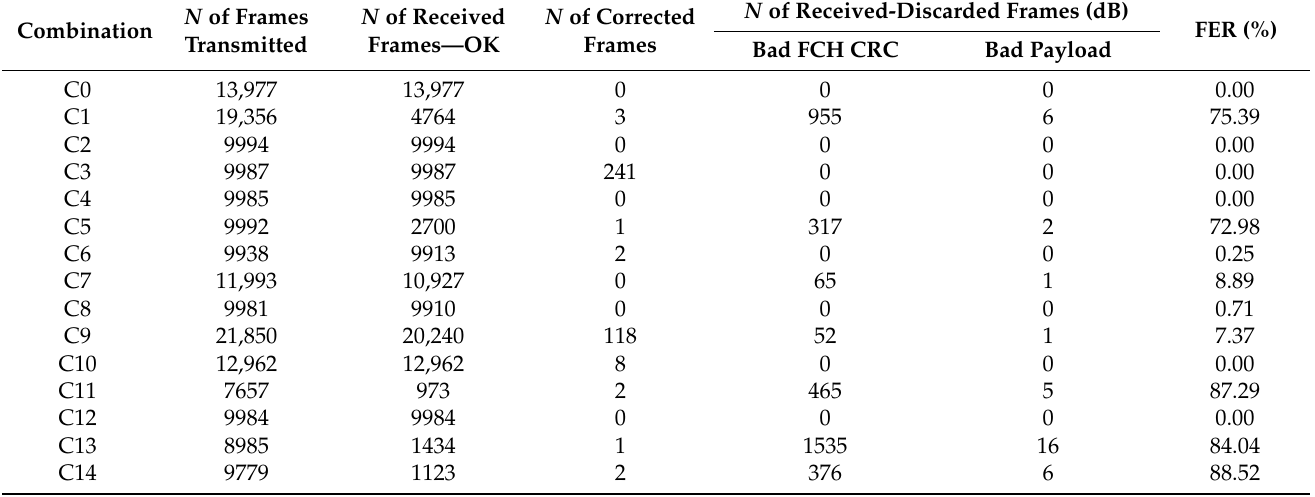
Table 5. Numbers ( N ) of transmitted and received (OK, corrected, and discarded) frames and calculated Frame Error Ratio